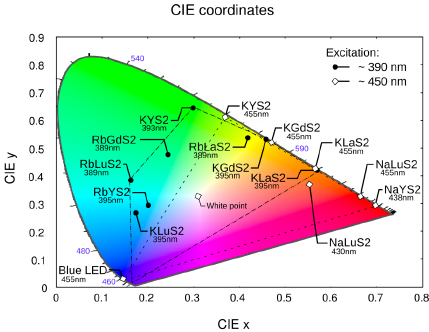
Figure 14. Commission Internationale de I’Eclairage (CIE) 1931 color coordinates calculated for samples under ~390 nm excitation (dark points, labeled inside) and ~450 nm excitation (empty diamonds, labeled outside)—Actual excitation is written below each sample label. Blue light emitting diode (LED) at 460 nm added for comparison. Lines denote colors available by mixing multiple materials under 390 nm and 455 nm excitation, respectively.